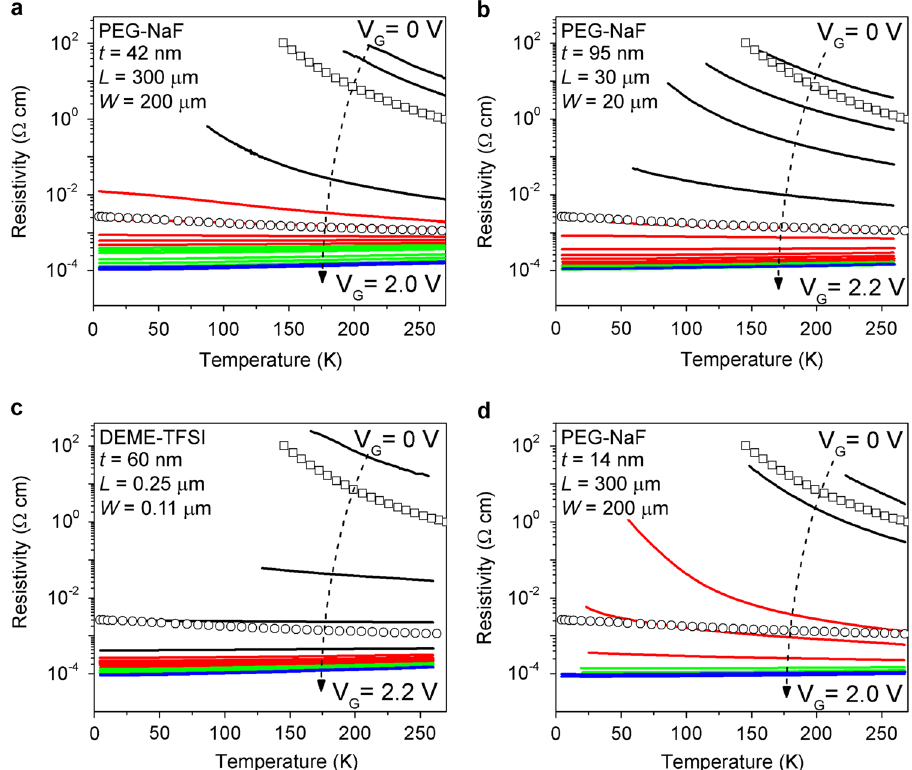
Fig. 2 Resistivity vs. temperature of WO 3 samples as a function of gate voltage. These four samples have different thicknesses ( t ), lengths ( L ) and widths ( W ): a , t = 42 nm, L = 300 µm, W = 200 µm; b , t = 95 nm, L = 30 µm, W = 20 µm; c , t = 60 nm, L = 0.25 µm, W = 0.11 µm; d , t = 14 nm, L = 300 µm, W = 200 µm. The gate voltage ( V G ) was varied in steps of 0.1 V for sample A, B, and D at 305 K and 0.2 V for sample C at 220 K. The electrolyte for sample C is DEME-TFSI while for the other three, it is PEG-NaF. As V G increases, the resistivity drops about fi ve orders of magnitude at 250 K, and all four samples show a similar insulator-to-metal transition. Curves denoted by “ □ ” and “ ○ ” are resistivity vs. temperature curves measured for a 30 nm thick WO 3 sample annealed in hydrogen forming gas at 500 and 520 °C for 1 h in sequence